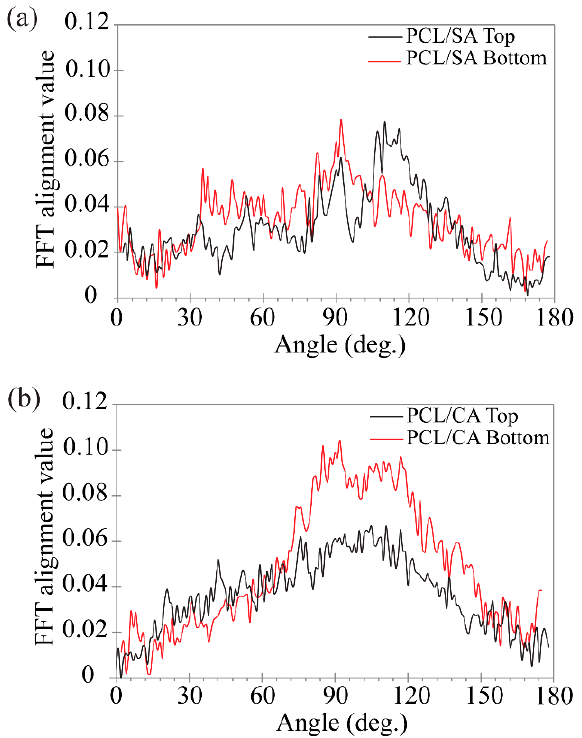
Figure 5. ( a ) Distributions and ( b ) statistical results of the estimated pore size at the top and bottom surfaces of the PCL/SA (uncrosslinked) and PCL/CA (crosslinked) scaffolds. The data suggest that fiber crosslinking resulted in the formation of more and smaller pores. Differences between the means of the datasets are not statistically significant ( p > 0.05). The outliers of the box plots shown in ( b ) are not shown for clarity.